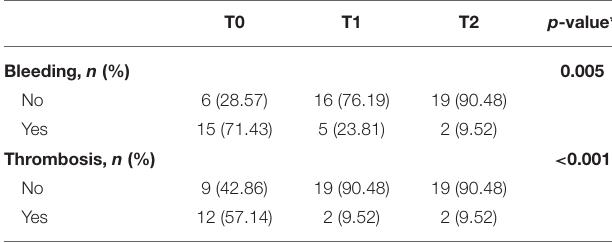
TABLE 4 | Clinical characteristics of the sample, stratified for time of observation. T0 T1 T2 p -value* Bleeding, n (%) 0.005